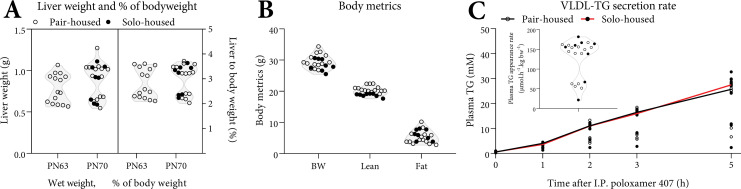
Liver weight, body weight, body composition and VLDL-TG secretion rate of C57BL/6JOlaHSD mice fed AIN-93G.Liver weight (A, left), bodyweight, lean tissue and fat tissue (B) at PN70 are expressed in absolute weights and relative liver weight as a percentage of body weight (A, right). Plasma triglyceride (TG) levels and the calculated Very-low density lipoprotein (VLDL)-TG secretion rate (μmol.h-1.kg BW-1, inset) expressed as the rate of plasma TG secretion over 5 h after I.P. injection of the lipoprotein lipase inhibitor (Poloxamer 407, 1 g/kg BW, C) at PN70. (C) represents a different cohort than (A-B) (see methods). A: n = 15 (PN63), n = 14 (PN70, pair-housed), n = 8 (PN70, solo-housed). B: n = 14 (PN70, pair-housed), n = 8 (PN70, solo-housed). Data are shown as scatter plots and violin plot. C: n = 14 (pair-housed), n = 8 (solo-housed). Data are shown as aligned scatter plots with the median line. Pair- (○) and solo (●)-housed mice.